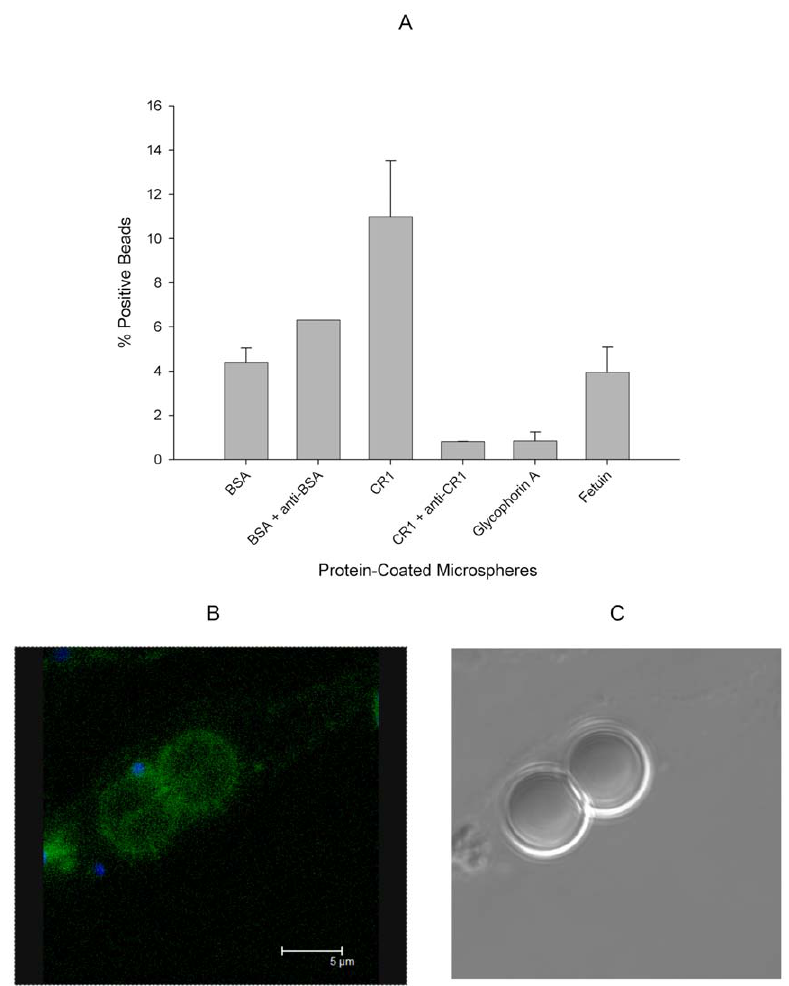
Figure 6. 7G8 merozoites bind preferentially to sCR1-coated microspheres. (A) Protein-coated microspheres were incubated overnight with purified late trophozoites and schizonts. Binding was detected by % of spheres positive for Hoechst staining using flow cytometry. Bars represent means 6 standard deviations. The figure represents a summary of 2–3 experiments except for the rabbit anti-BSA which was included in one experiment. (B) Fluorescence image of sCR1-coated microspheres showing attached merozoites (blue) and surface sCR1 (green). (C) Differential interference contrast image of microspheres in B.